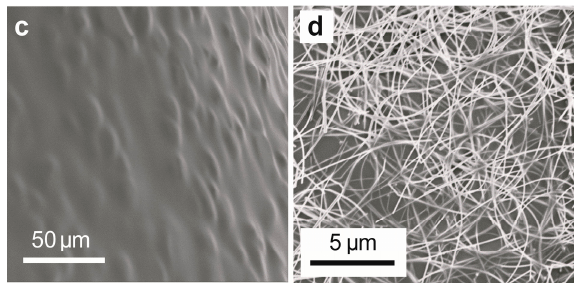
Figure 2. Scanning electron microscope images of the stretchable ACEL fiber. ( a , b ) Cross-section images of stretchable ACEL fiber with different magnifications. Inset shows detailed image of AgNWs sandwiched by PDMS and ZnS:Cu/PDMS composite layers. Scale bar is 4 μ m. ( c ) Surface morphology of light-emitting layer. ( d ) AgNWs on the ZnS:Cu/PDMS composite surface.